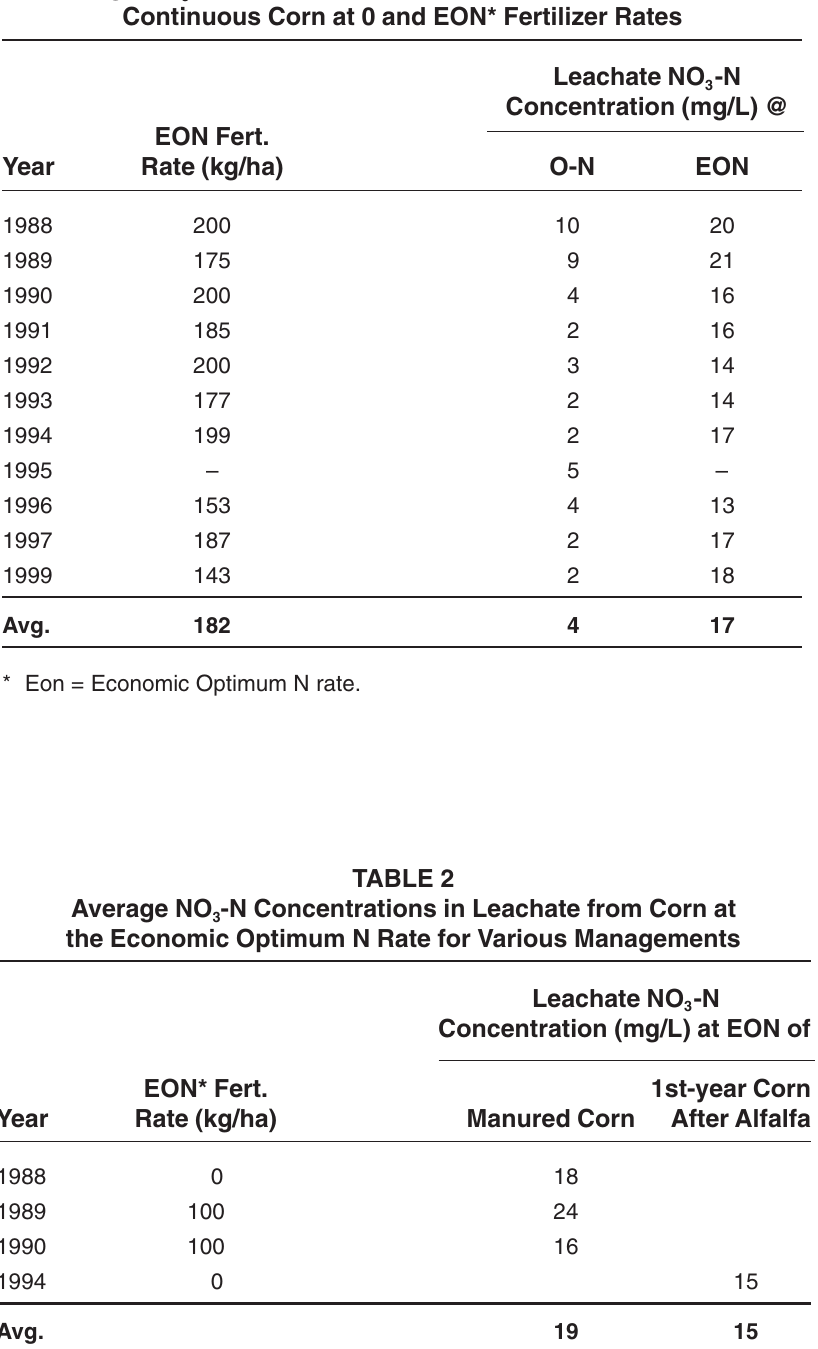
Average NO -N Concentration in Leachate from Non-Manured 3 Continuous Corn at 0 and EON* Fertilizer Rates